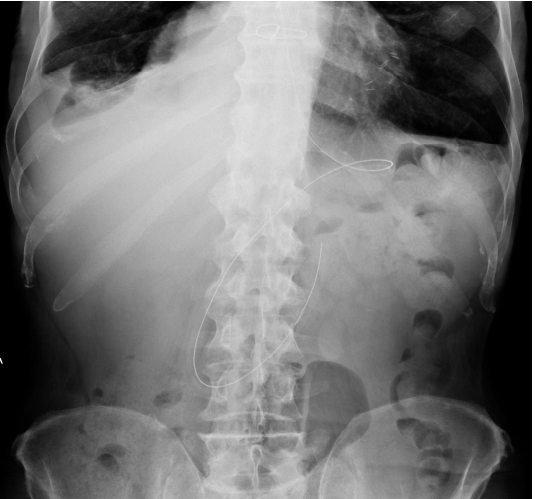
Figure 24. Abdomen X-ray showing the image of a NG tube that has been pushed too deep and reached the distal duodenum.